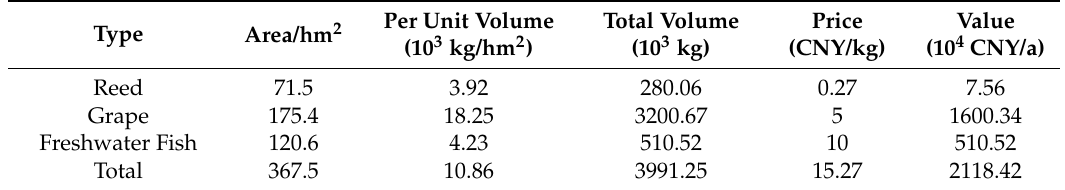
Table 4. The material production value of Lakeside Wetland Park.